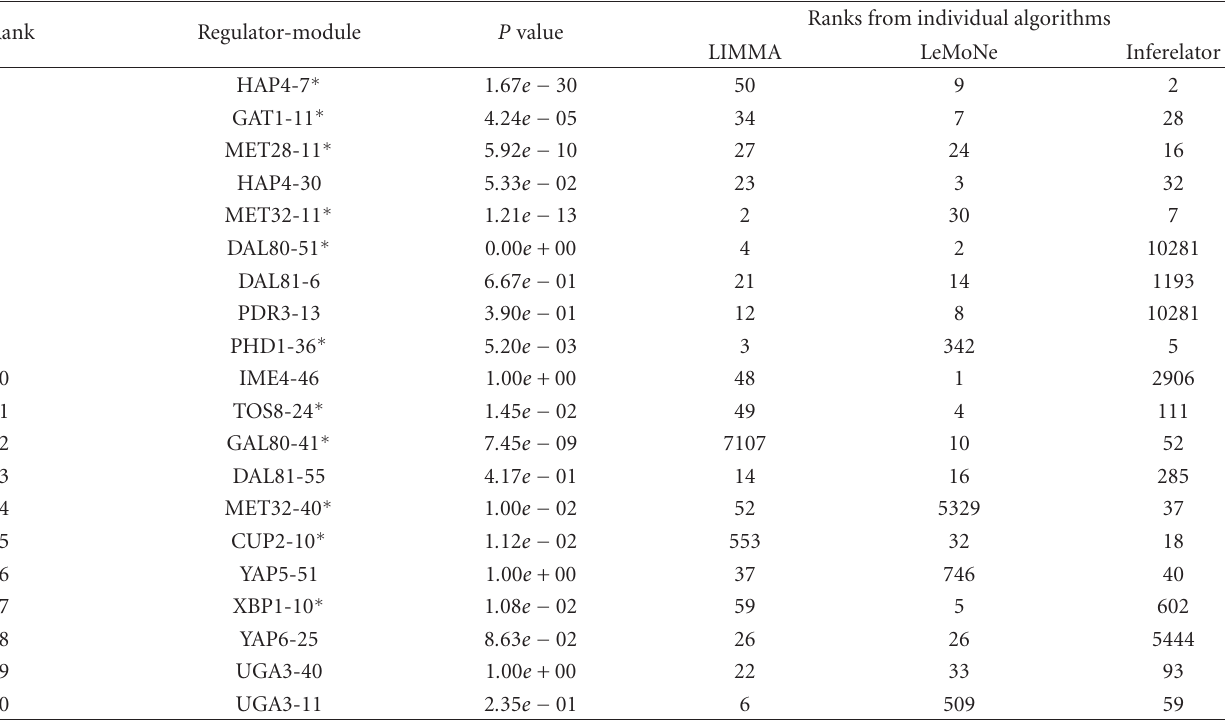
Table 2: Top twenty regulator-module interactions as given by the weighted rank aggregation method. ∗ Records represent true positives at the P value threshold of